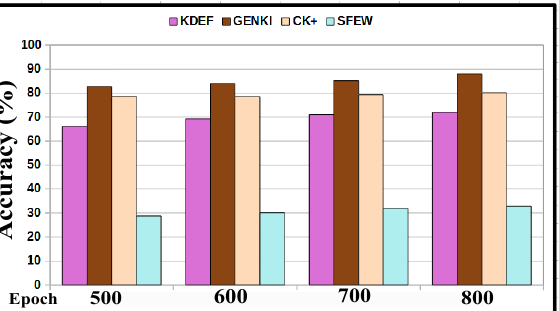
Figure 12. Effect on the performance of the proposed FERS while keeping the batch fixed with varying epochs using CNN 1 architecture for the KDEF, CK+, and SFEW database.